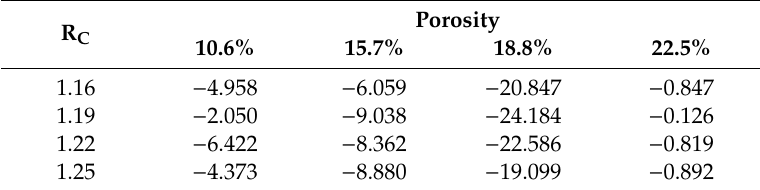
Table 3. Static pressure percentage variation due to wall ventilation at the upstream proximity (X = 0.48 L).